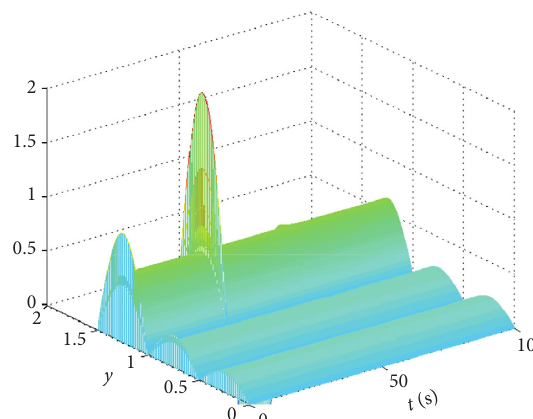
Figure 6: The output PDF with the proposed FTTC